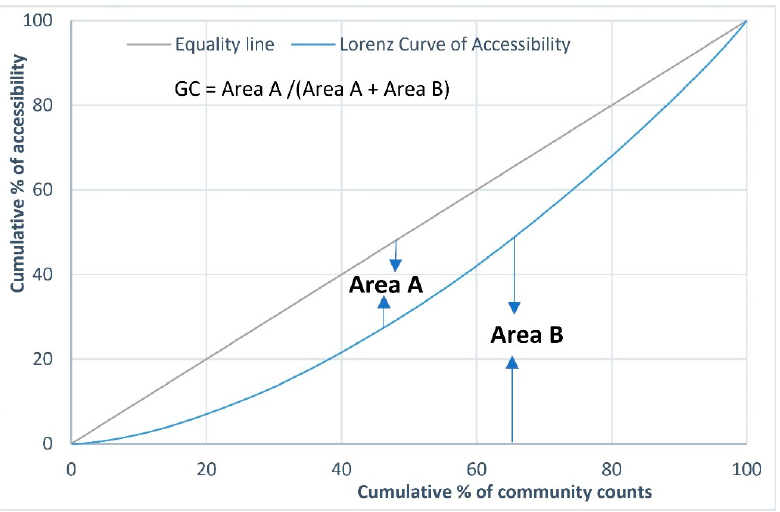
Figure 2. Illustration of Lorenz curve and Gini